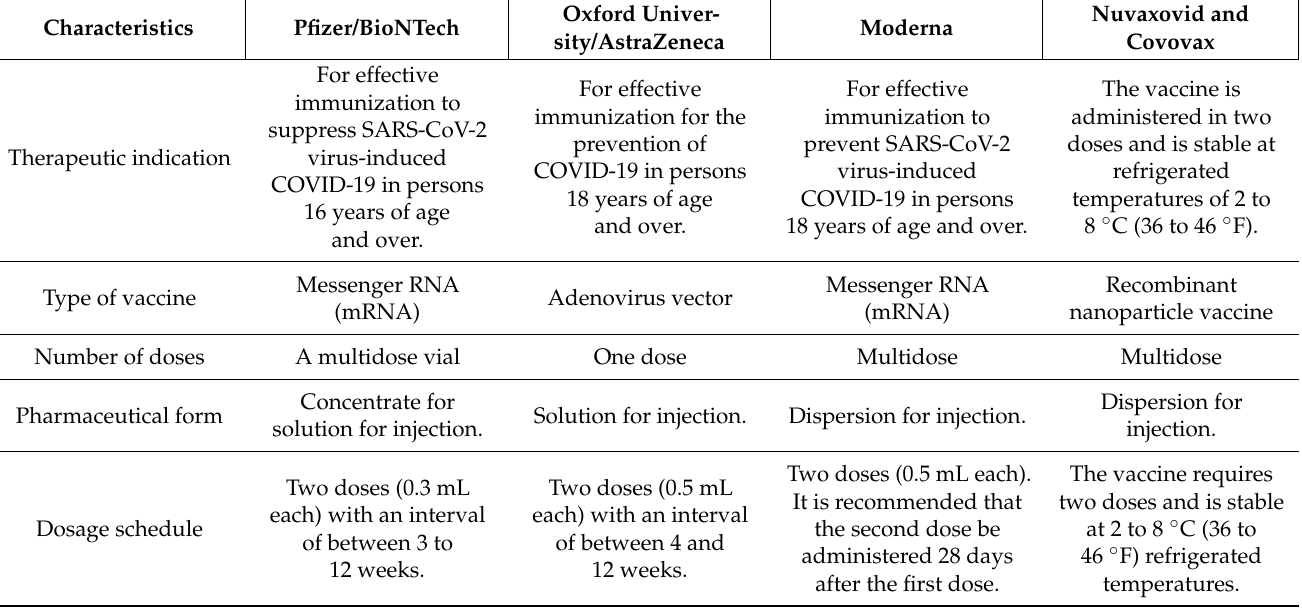
Table 3. Characteristics of the Pfizer/BioNTech, Oxford University/AstraZeneca, and Moderna vaccines